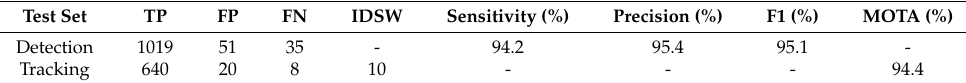
Table 1. Evaluation results for the pig detection set and tracking